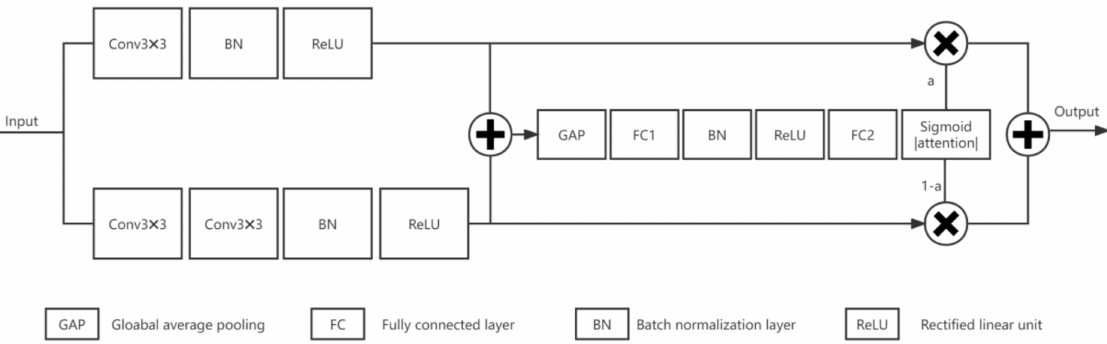
Figure 5. Schematic diagram of the structure of the improved SK module. The SK block consists of two branches. The first one utilizes one conventional 3 × 3 convolutions, while the second one uses two 3 × 3 convolutions to generate a perceptual field of